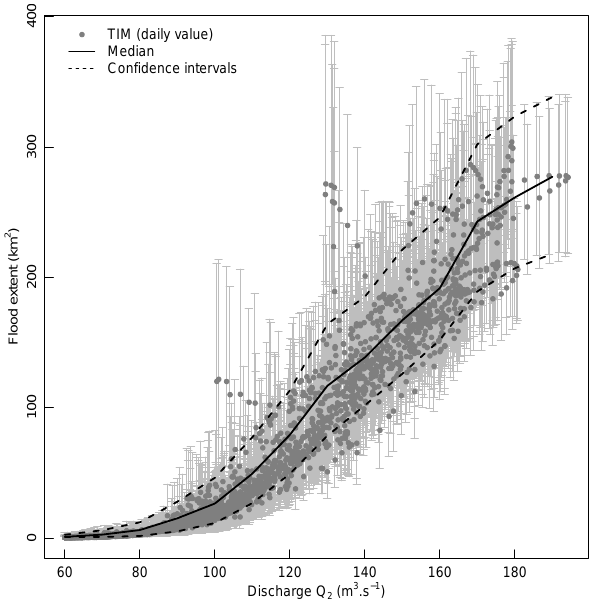
Fig. 9. Relationship between discharge at the delta inlet Q 2 , and flood extent A , as computed by TIM. Error bars depict the 10th and 90th percentile values. “Median” and “Confidence intervals” depict the median values calculated from the median, 10th and 90th per- centiles of